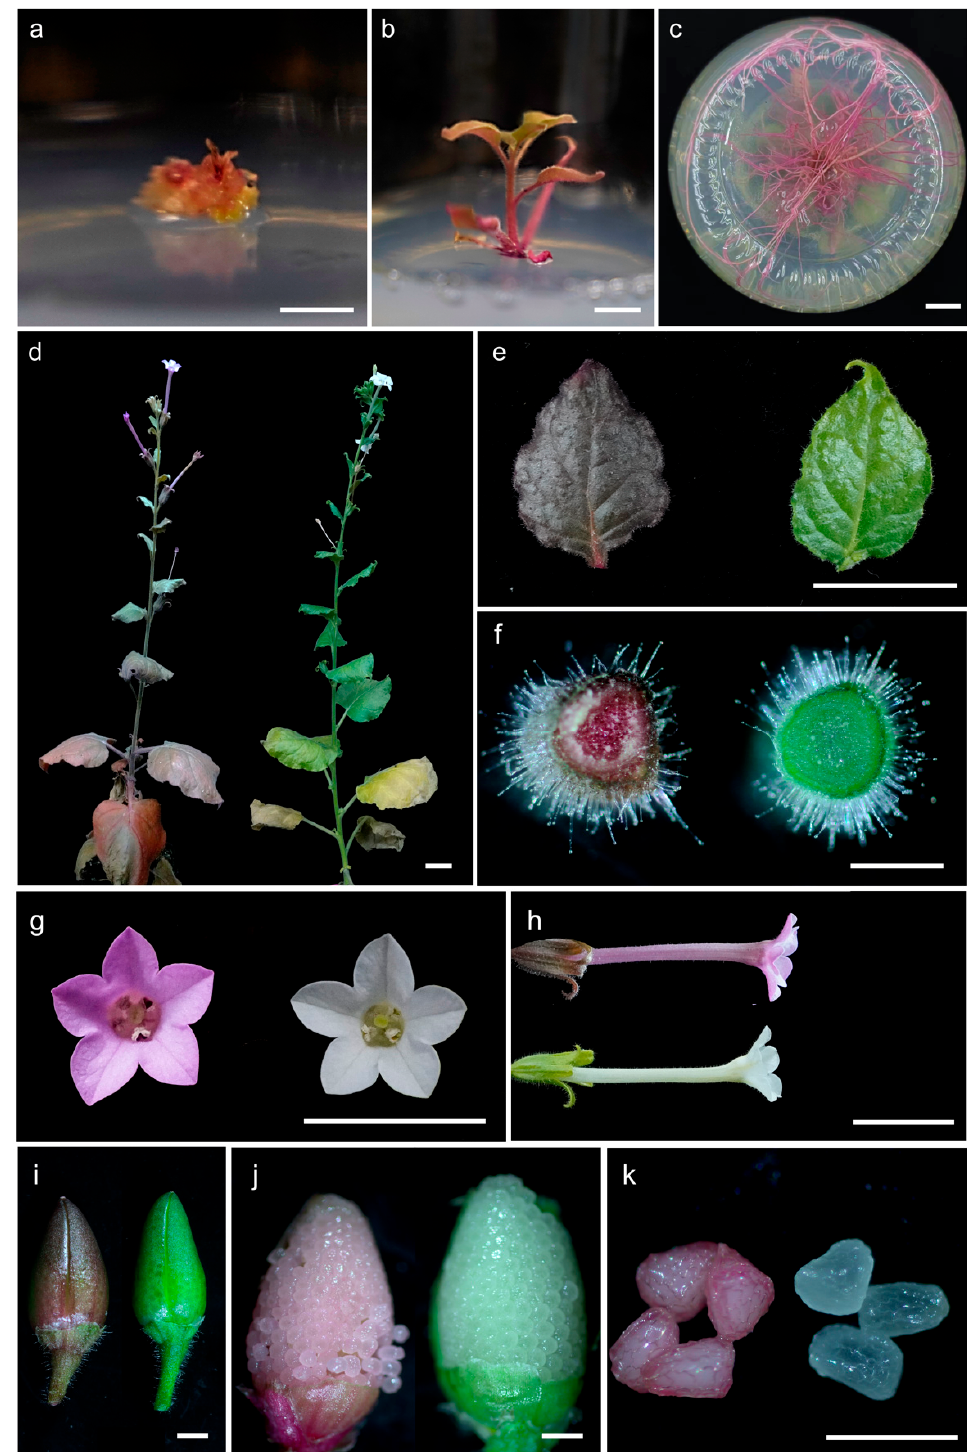
Figure 3. The phenotype analysis of RUBY transgenic N. benthamiana plants. ( a , b ) RUBY transgenic adventitious bud regenerated from N. benthamiana leaf. ( c ) RUBY transgenic N. benthamiana plant induced roots. ( d ) The whole plant morphology of RUBY transgenic N. benthamiana (left) and WT (right), the same below. The leaf ( e ), stem ( f ), flower ( g , h ), and fruit ( i ) morphology of RUBY transgenic N. benthamiana and WT. Peeled semimature fruit ( j ) and seeds ( k ). (Scale bars in ( a – e , g , h ) = 1 cm, scale bar in ( f , i – k ) = 1 mm).